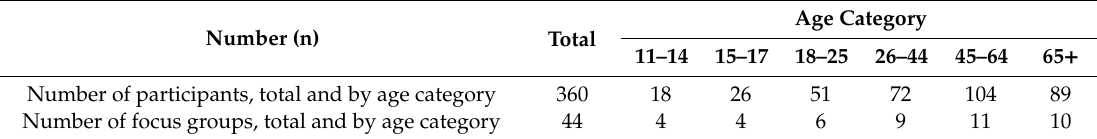
Table 1. Numbers of Participants and Focus Groups, Total and by Age